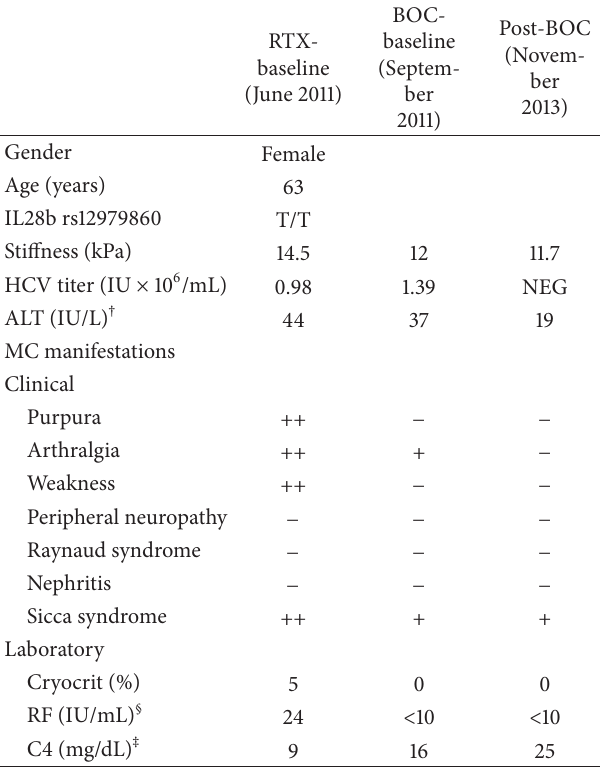
Table 1: Main clinical and laboratory data before rituximab (RTX- baseline), 2 months after rituximab cycle (BOC-baseline), and at the end of follow-up after boceprevir-based antiviral therapy (post-